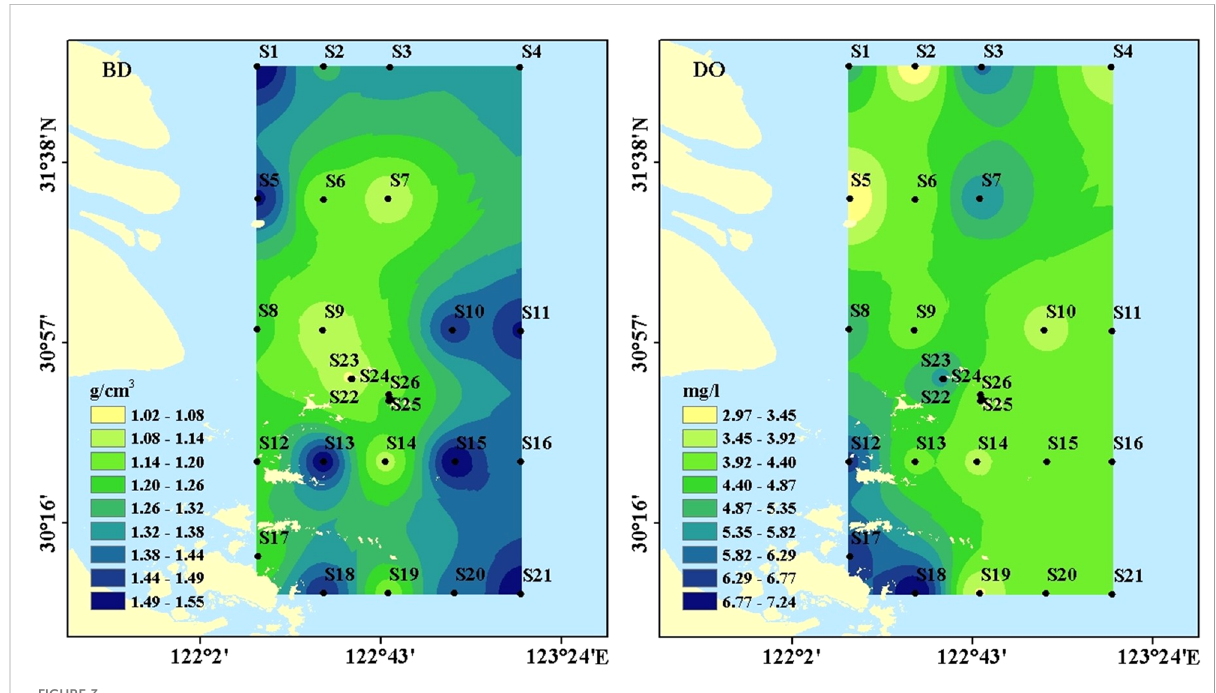
FIGURE 3 BD and DO distribution in the surface sediment of this work.